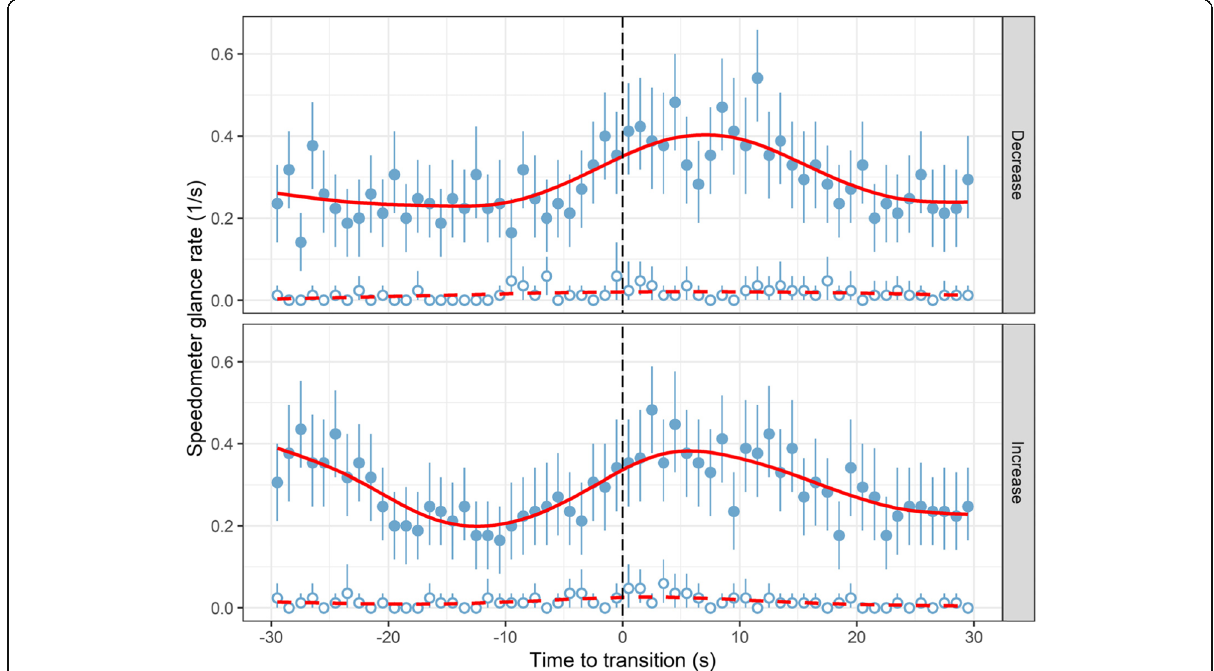
Fig. 12 Speedometer glance rate glances relative to the speed limit transitions. Mean and 95% CI shown with points and ranges, with loess smoothed solid red line. For comparison, speed app glance rates on the bottom of the figures for comparison (the circles with ranges, with loess smoothed dashed red line). Separate figures for the speed limit decreases and increases. Glance rates are averages over all the participants and